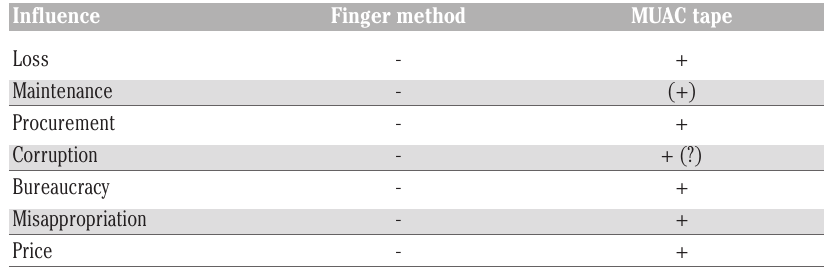
Table 1. Investigators experience with the two